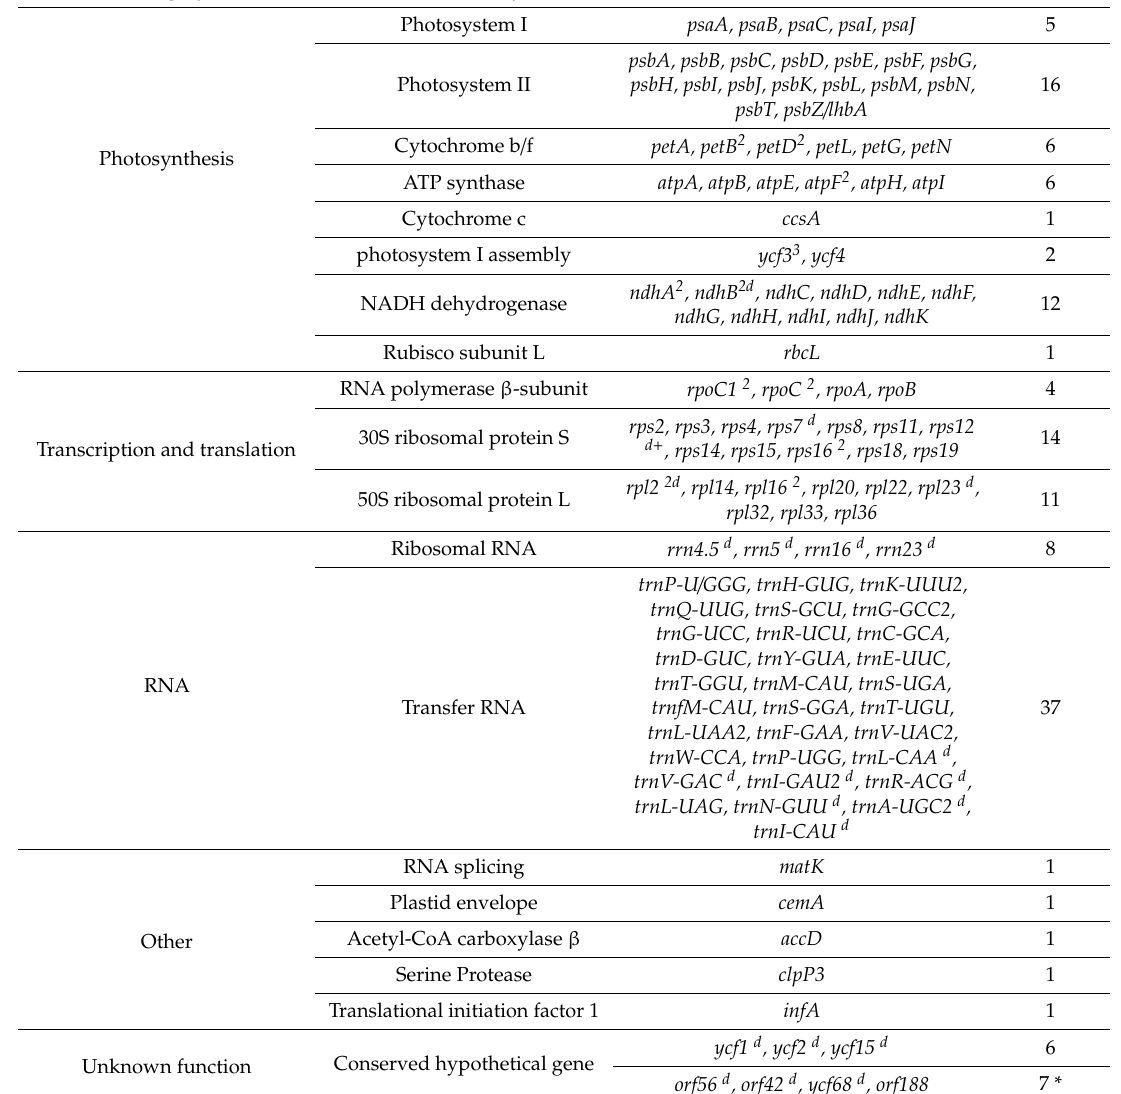
Table 2. List of annotated genes in the plastid genome of Ilex